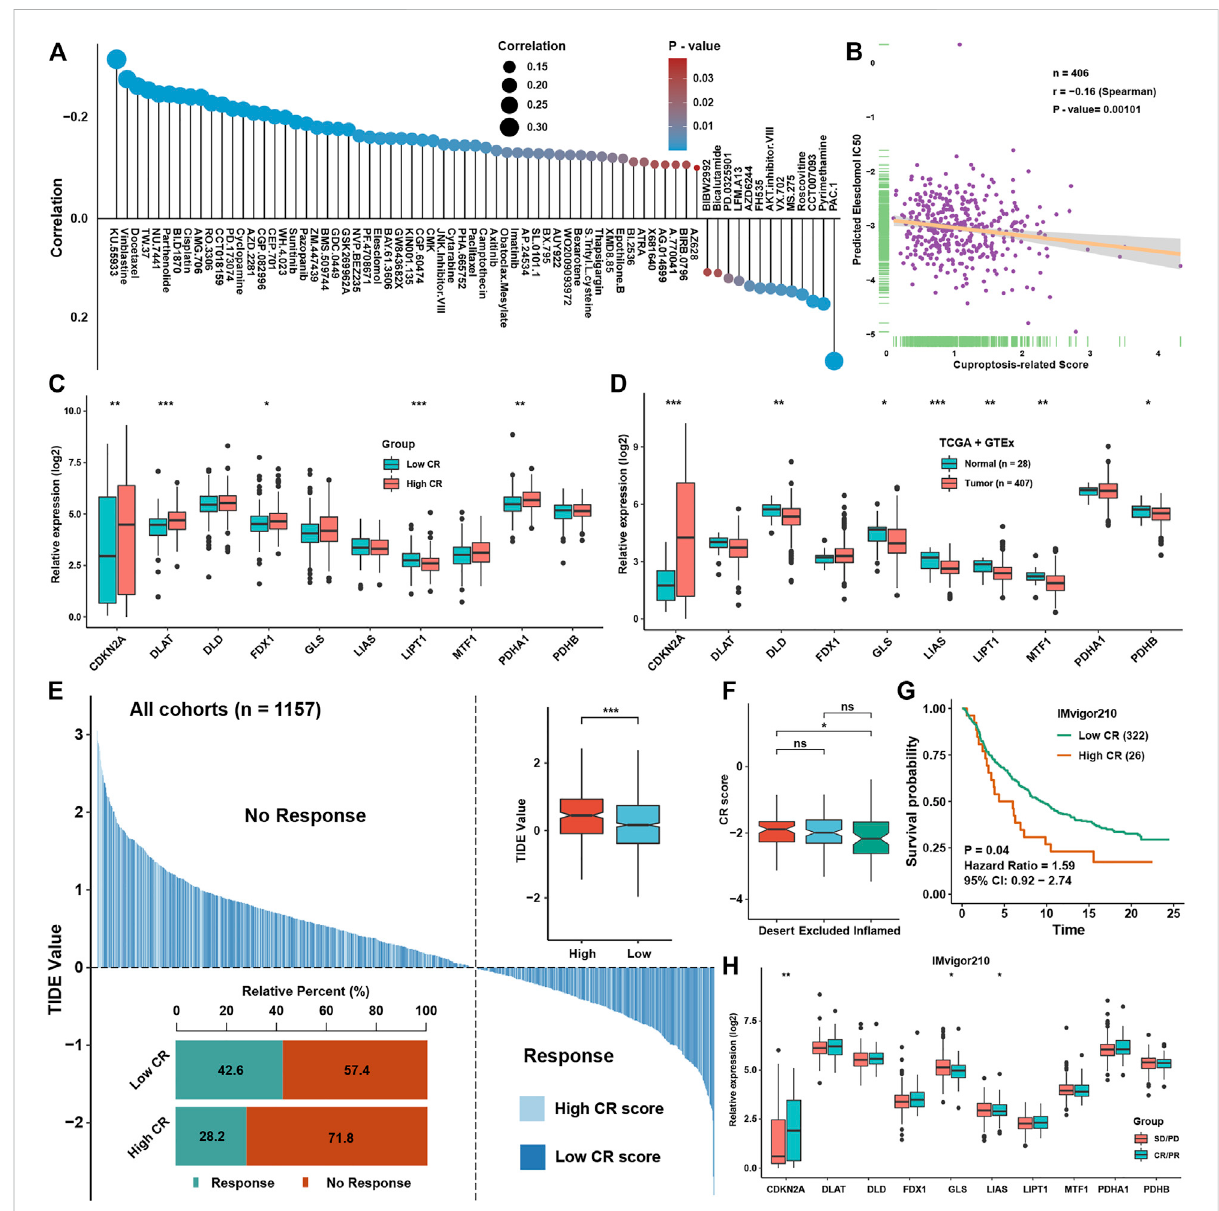
FIGURE 8 Prediction of chemotherapy and immunotherapy ef fi cacies of CR scores in BLCA (A) . The correlation analysis between CR scores and predictionIC50ofdrugsintheGDSCdataset (B) .ThecorrelationanalysisbetweenCRscoresandpredictionIC50ofElesclomolintheGDSCdataset (C) . The expression levels of cuproptosis regulators between low and high CR score groups (D) . The expression levels of cuproptosis regulators between normal and BLCA tissues in GTEx and TCGA datasets (E) . The TIDE value of BLCA samples was shown for different CR score groups, and the chi-square test used to assess signi fi cant differences is shown in the bottom-left side. The risk scores and TIDE values in different response groupsandCRgroupsareshownintheupper-rightside (F) .TheabundanceofCRscoresindifferentimmunesubtypesintheIMvigor210cohort (G)